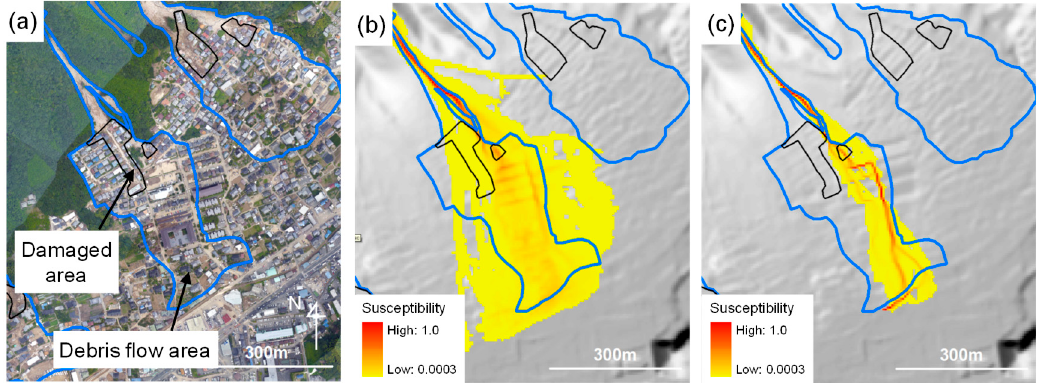
Figure 8. ( a ) Debris flow area with post-event aerial photograph observed after the 2014 event in Hiroshima. ( b ) Debris flow propagation area by Flow-R analysis based on the parameters in Table 3. ( c ) Debris flow propagation area by Flow-R analysis based on Gamma’s criteria [44] for weights in